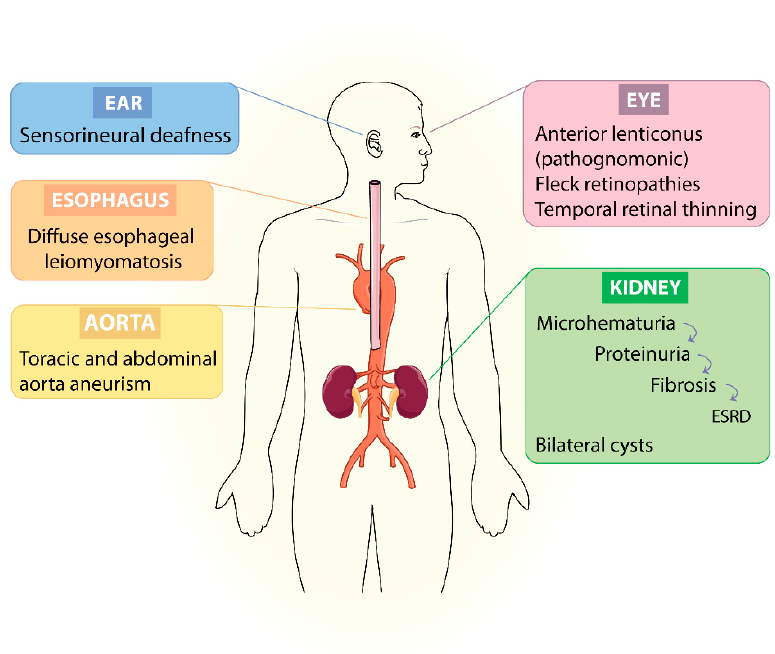
Figure 1. Main defining phenotypic characteristics of Alport